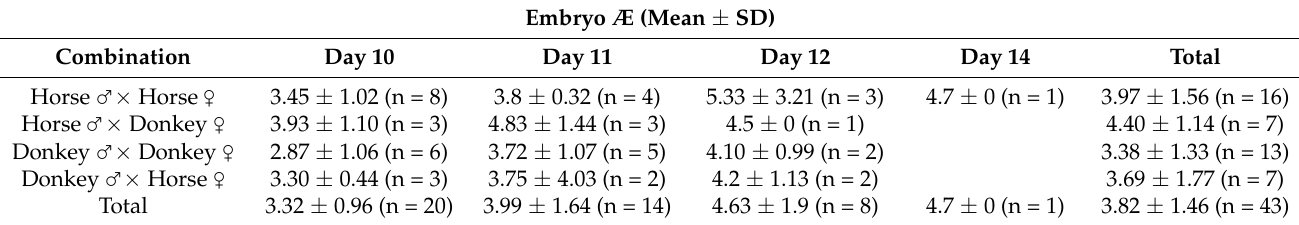
Table 3. Embryo diameters (mean ± SD) in mm at pregnancy diagnosis in horse and donkey females inseminated with horse and donkey semen, according to the day of embryo detection. ( p > 0.05).